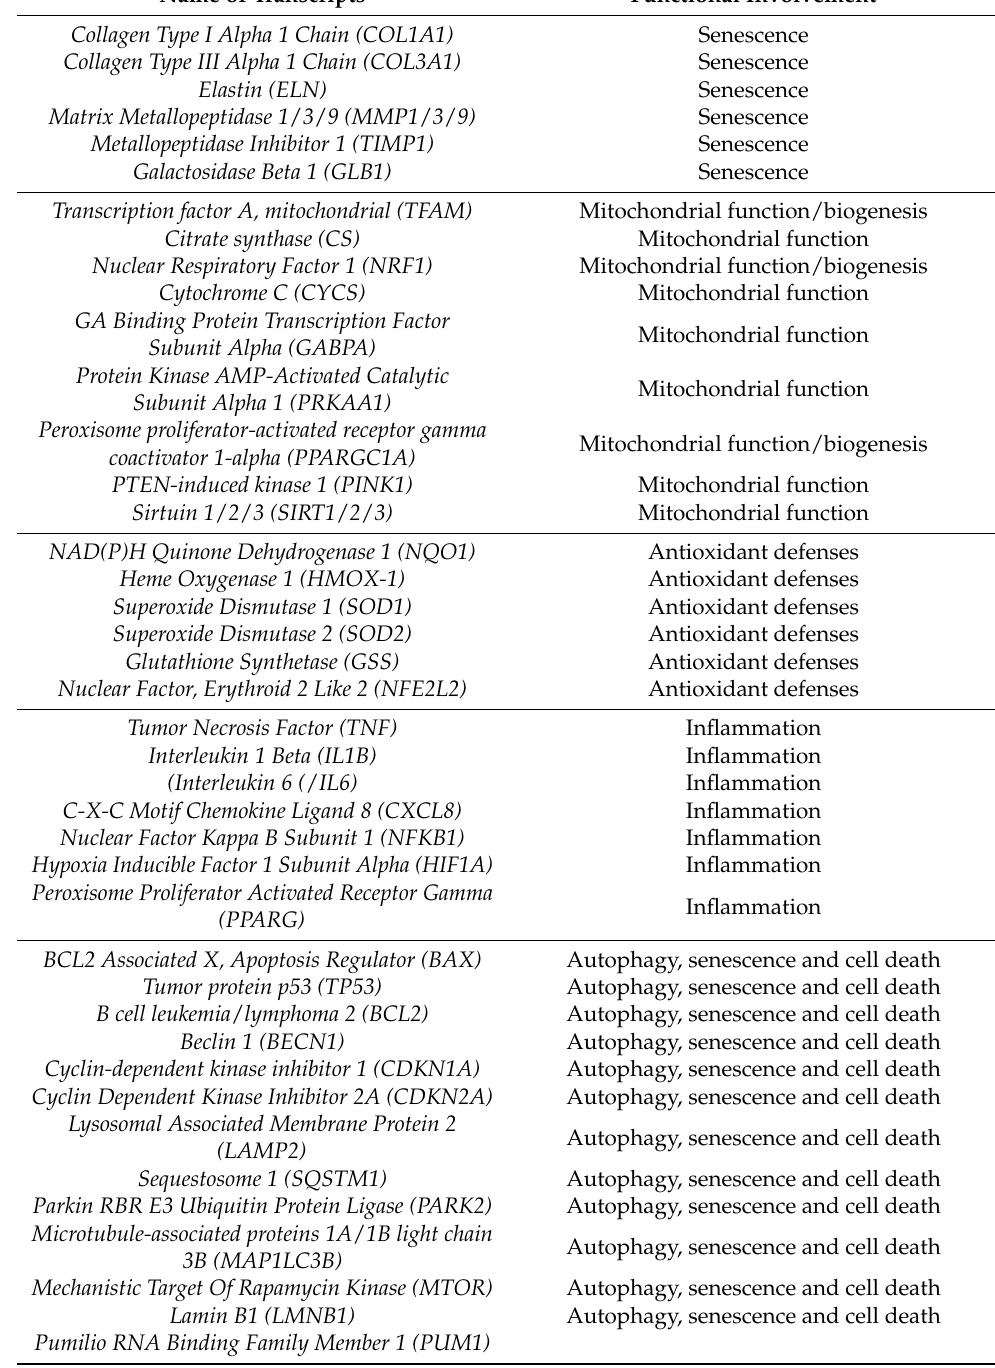
Table 1. Name of transcripts and respective functional